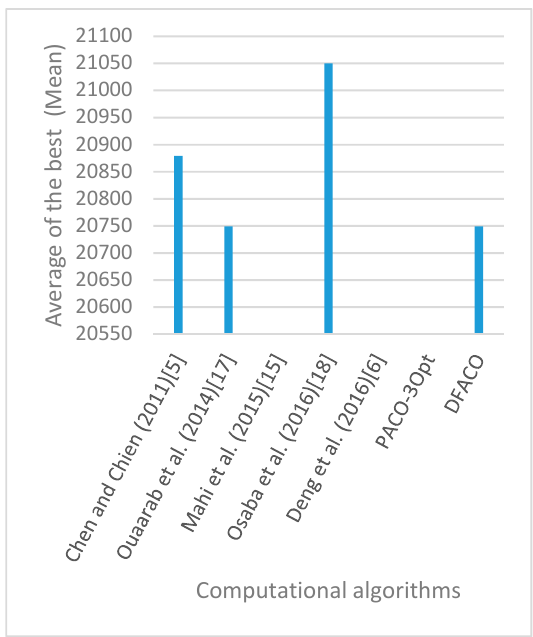
Figure 24. Average of best solutions obtained for instance kroC100 by all algorithms.